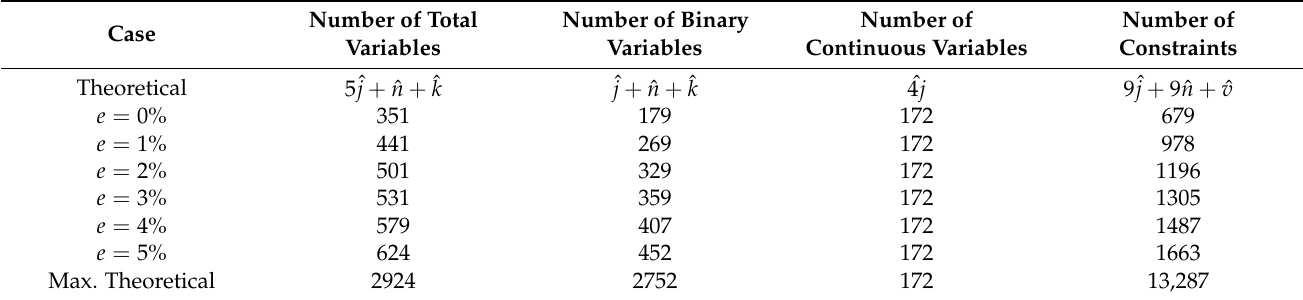
Table 6. Number of variables and constraints under several tolerance factor values ( e